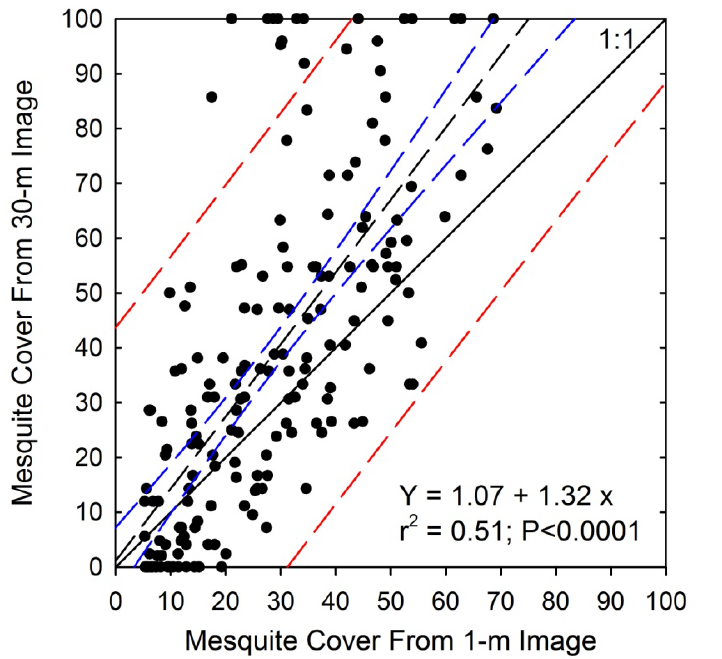
Figure 6. Scatter plot between mesquite cover in 183, 4-ha sub-cells determined from 1-m and 30-m images. Lines are a 1:1 line (solid line), and linear regression (black dashed line), with 95% confidence band (blue dashed lines) and 95% prediction band (red dashed lines). Points that were <5% cover from x axis in Figure 5(a) were not